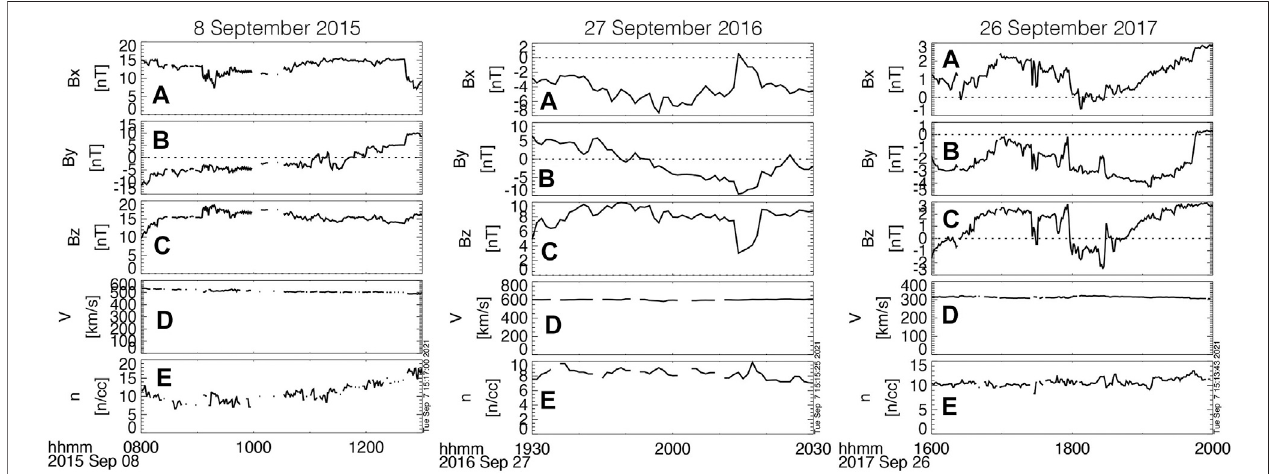
FIGURE 7 | Solar wind conditions from OMNI during the (left) September 8, 2015 (center) September 27, 2016, and (right) September 26, 2017 events. Panels include (A) interplanetary magnetic fi eld (IMF) B X GSE component, (B) IMF B Y GSE component, (C) IMF B Z GSE component, (D) solar wind bulk speed, (E) solar wind proton number